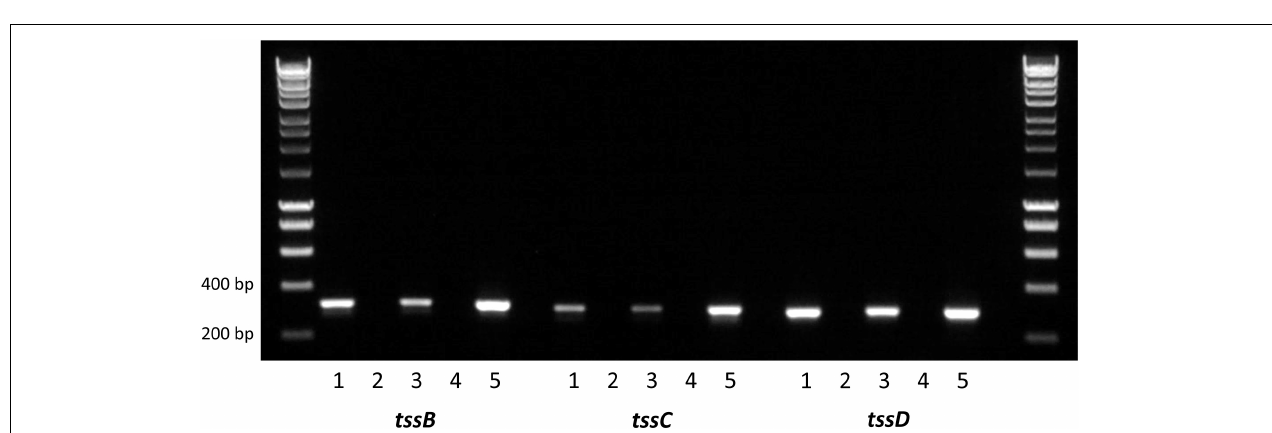
FIGURE 1 | Type VI secretion system gene clusters of C. jejuni strains. The C. jejuni 488 and 43431 wild-type strains were sequenced using whole genome sequencing in this study. The genome sequence of C. jejuni RC039 was published by Corcionivoschi et al. (2015). The genome sequences for C. jejuni 108 and C. coli RM2228 was published by Bleumink-Pluym et al. (2013). The genome sequence for C. jejuni 414 was published by Lertpiriyapong et al. (2012).